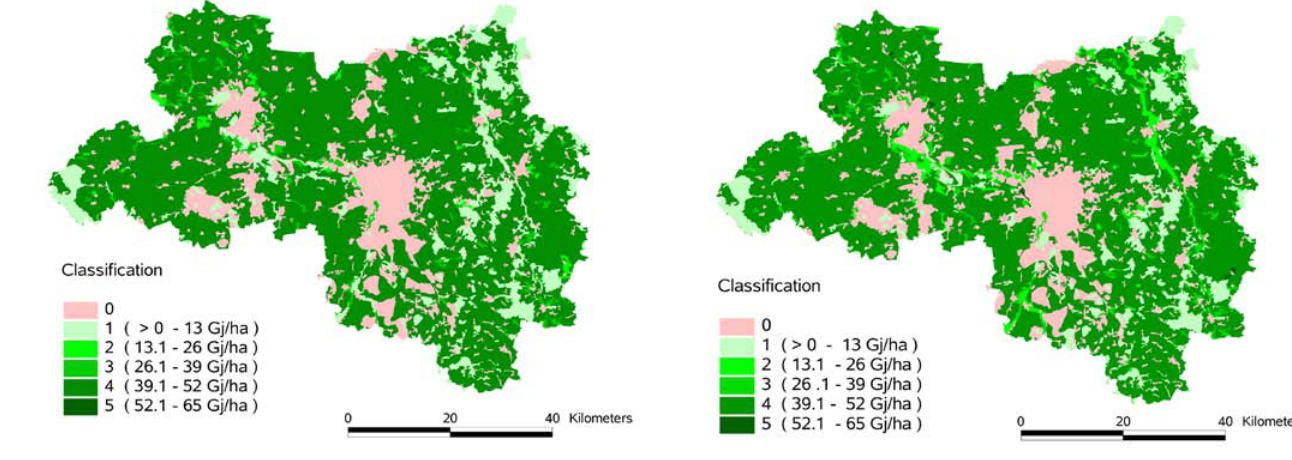
Figure 3: Spatial distribution of the ecosystem service “crop provision” in the year 1990 (left) and 2000 (right) for the region of Leipzig, Halle, and surrounding districts.